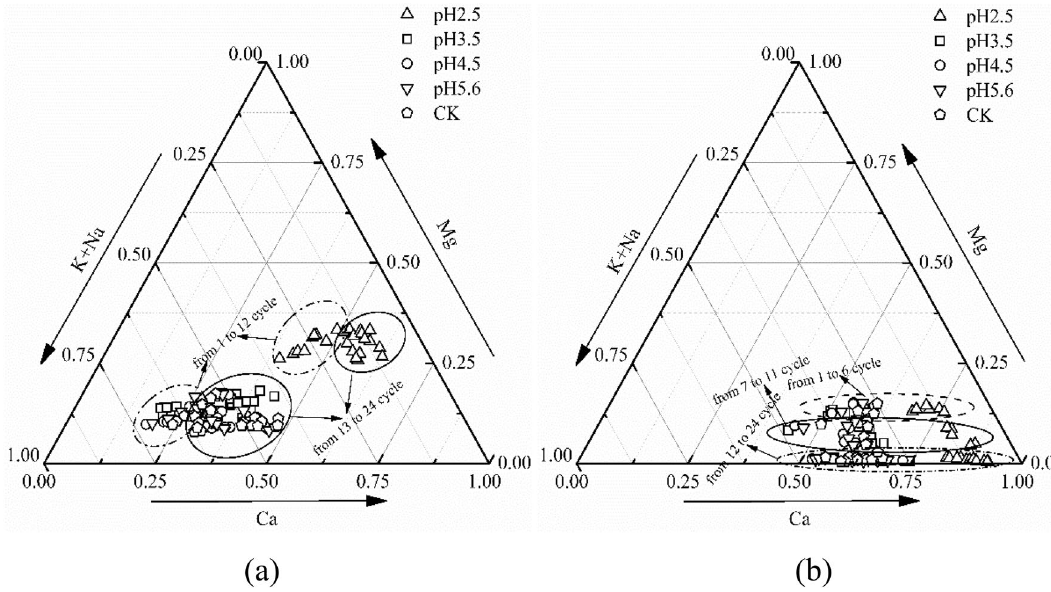
Figure 5. Ternary diagrams showing the cation compositions of purple rocks J 2 s ( a ) and J 3 p ( b ) from the filtered solutions used in the present